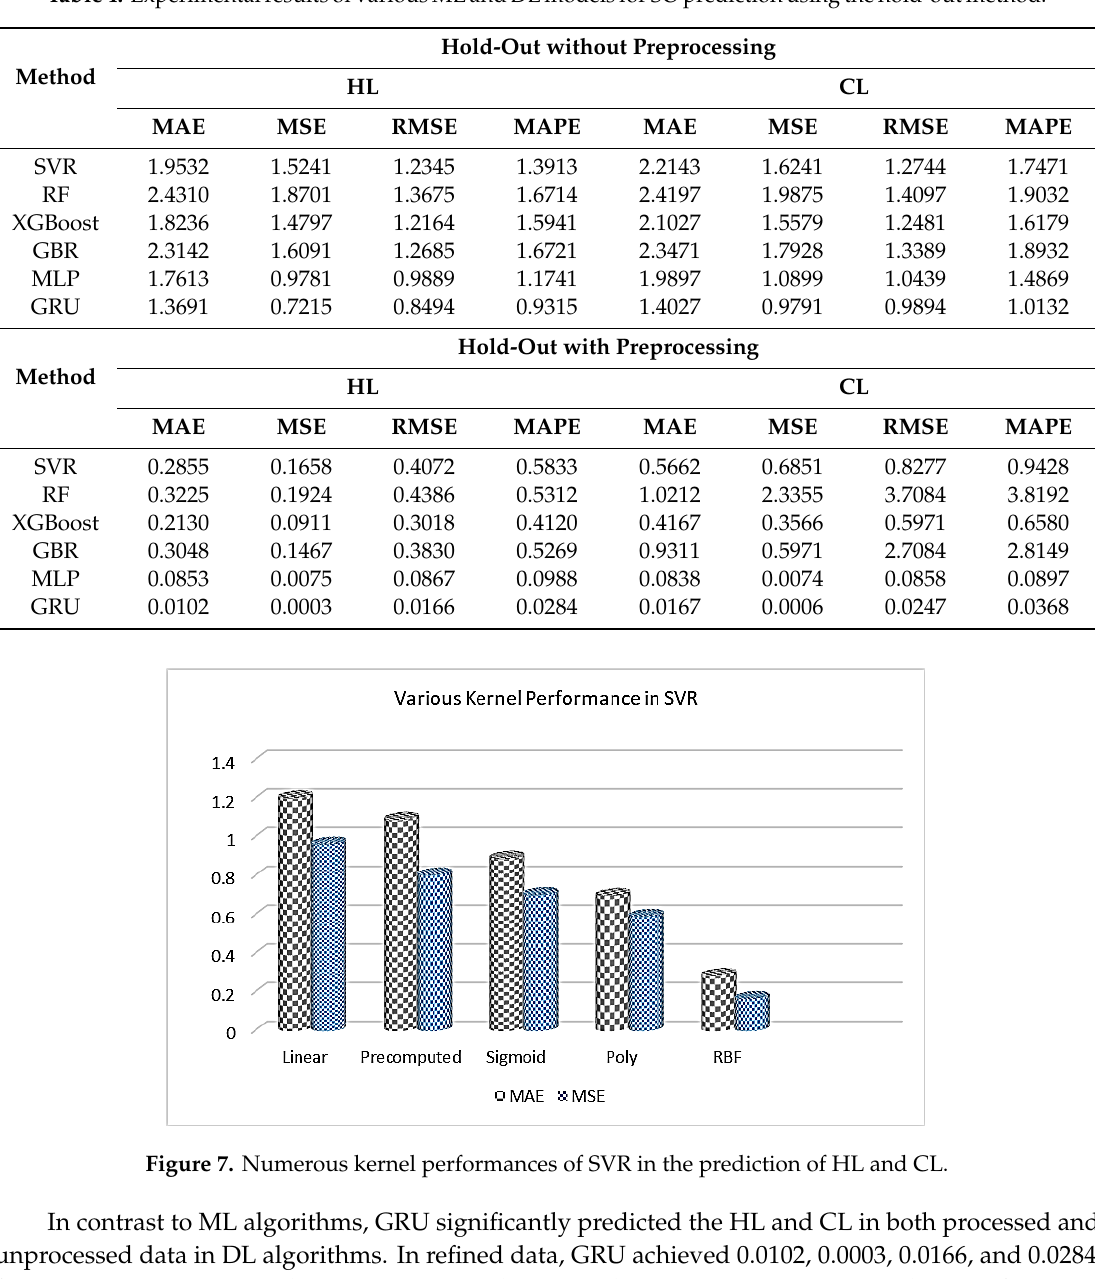
Table4. ExperimentalresultsofvariousMLandDLmodelsforSOpredictionusingthehold-outmethod.